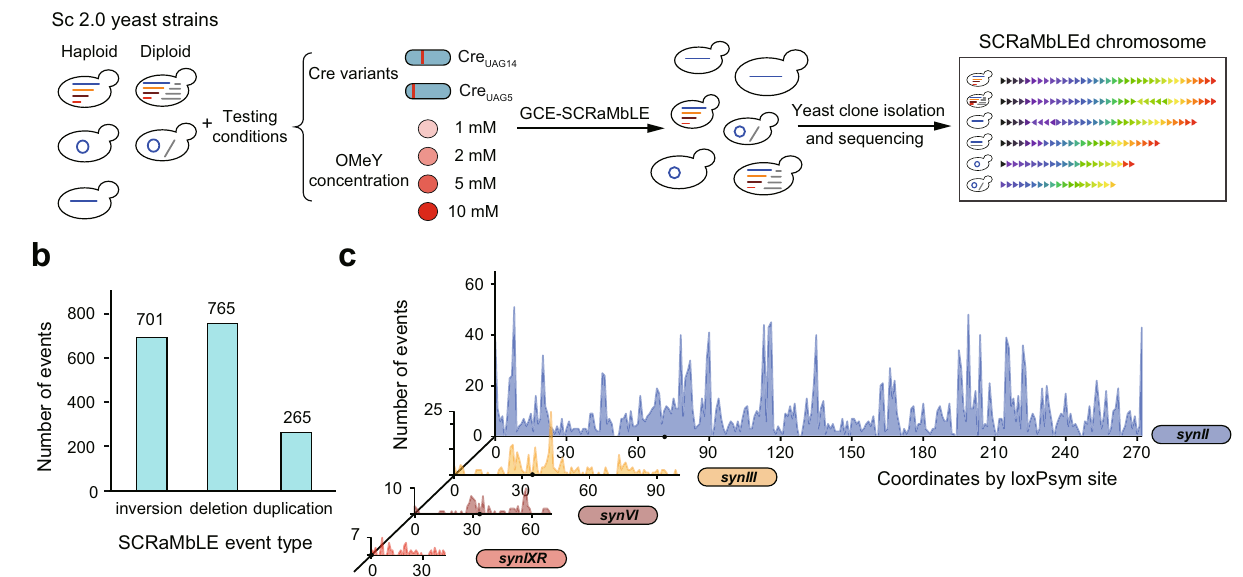
Fig.2|TheexperimentdesignandresultingrearrangementlandscapeviaGCE- SCRaMbLE. a Schematic diagram showing the work fl ow of GCE-SCRaMbLE. A series of Sc2.0 yeast strains were used in this study: haploid and diploid yeasts harboring a synII , a ring_ synII (the circular form of synII ) and multiple synthetic chromosomes ( synII , synIII , synVI , and synIXR ). Testing conditions included four concentrations of OMeY (1, 2, 5 and 10mM) for Cre UAG14 and one concentration of OMeY (1mM) for Cre UAG5 , which led to a total 23 groups of synthetic yeast strains subject to GCE-SCRaMbLE (see supplemental Table 1 for the design details). 60 colonies of SCRaMbLEd strains were randomly picked up from each group for whole genome sequencing and analysis. The SCRaMbLEd chromosome is repre- sented as a sequence of arrows in which the color of each arrow indicates the